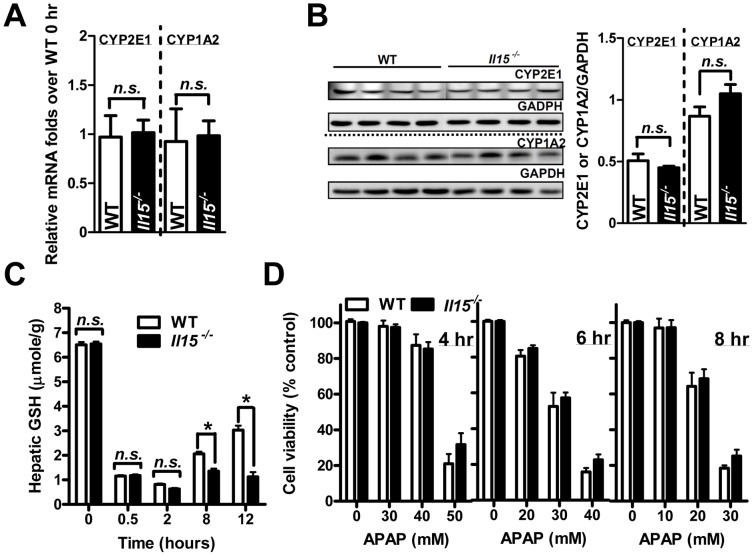
Hepatic metabolism of APAP does not contribute to the enhanced susceptibility to AILI in Il15−/− mice.The changes in APAP metabolic enzyme levels by analysis of hepatic mRNA and protein levels of CYP2E1 and CYP1A2 by (A) quantitative PCR and (B) western blot analysis and quantification. GAPDH served as the loading control. (C) Hepatic GSH levels at 0, 0.5, 2, 8 and 12 hr after APAP treatment. (D) Viability of isolated primary hepatocytes after treatment with 0 to 50 mM of APAP for 4 to 8 hr. *P<0.05; n.s., not significant. Data are mean ± SEM from 7∼8 mice per group.